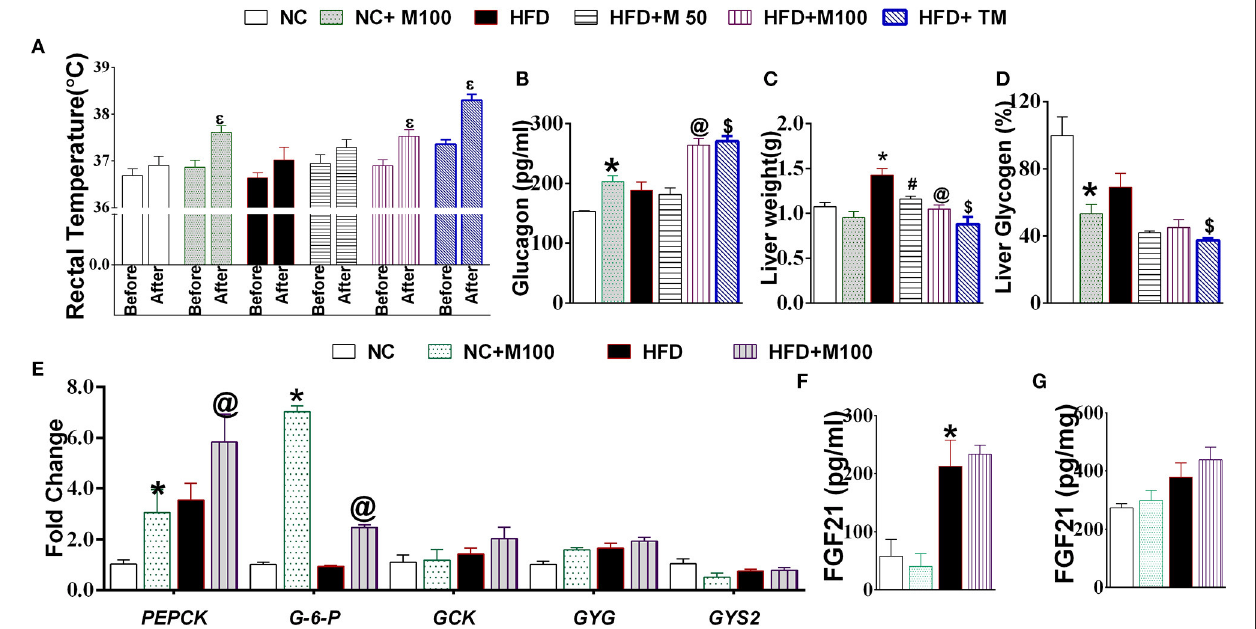
FIGURE 3 | Effect of chronic administration of menthol on glucagon dependent machinery in liver. (A) Rectal temperature before and 2h after menthol treatment, n = 5; (B) Serum glucagon, n = 5; (C) Liver weight, n = 5; (D) Liver glycogen, n = 5; (E) Expression of gluconeogenic marker genes in liver, n = 3; (F) Serum FGF21, n